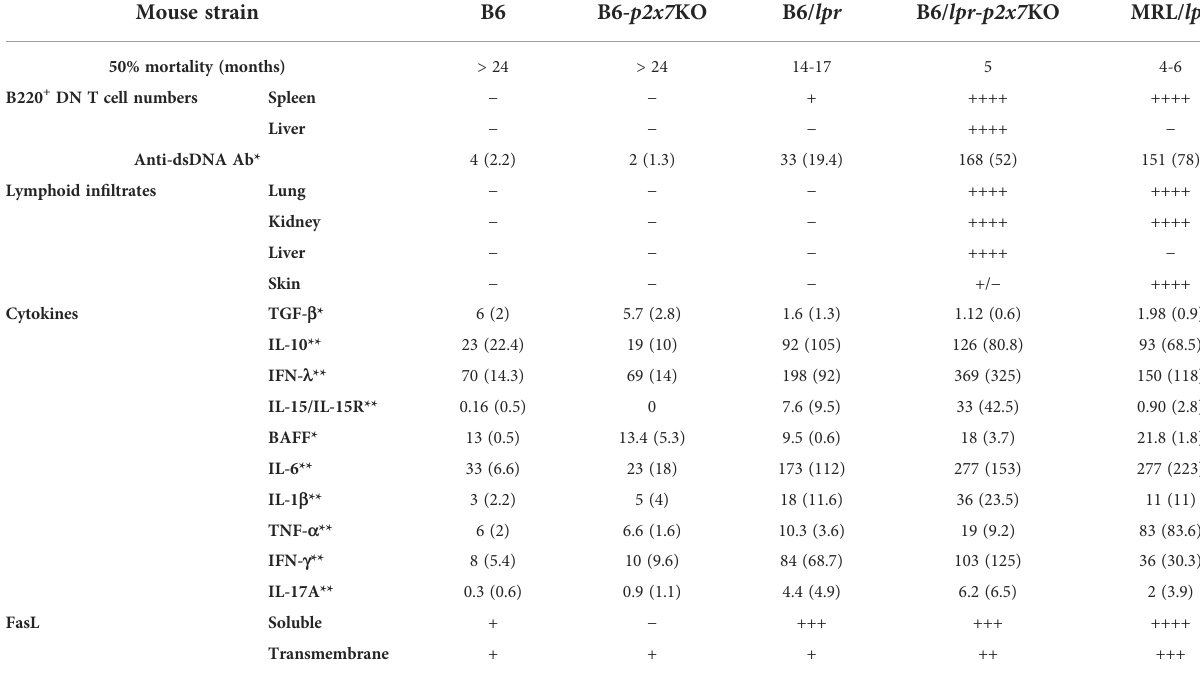
TABLE 2 Summary of the major phenotypic characteristics of B6/ lpr - p2x7 KO mice compared to parental strains and the MRL/ lpr mouse model of ALPS and SLE